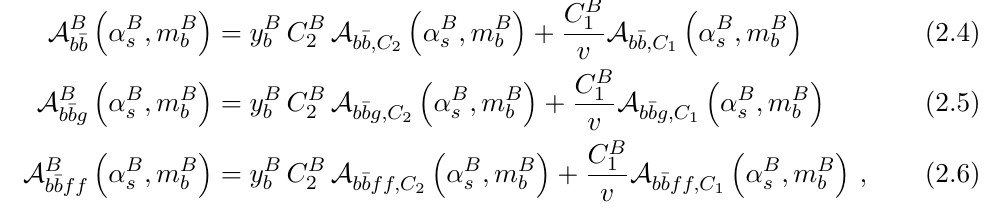
Figure 3. Representative Feynman diagrams for the EFT-induced contributions at order O ( α 3 computed in this paper. Unlike at O ( α 2 ) (left), the different phase-space contributions are no longer s separately infrared finite. The three-body phase-space contribution is particularly complicated since it has contributions which correspond to the real corrections for the two-body final-state, with the total contribution serving as the virtual corrections to the 3-body